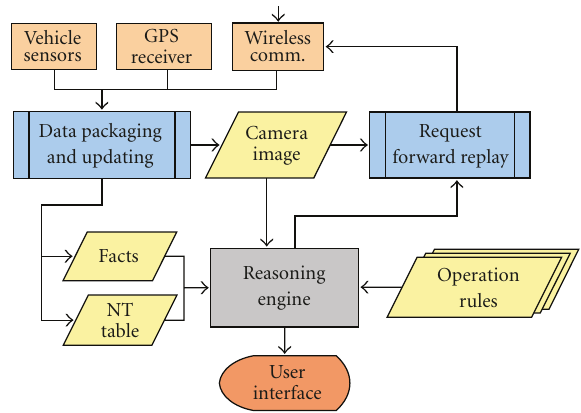
Figure 9: The block diagram of a system based on the proposed